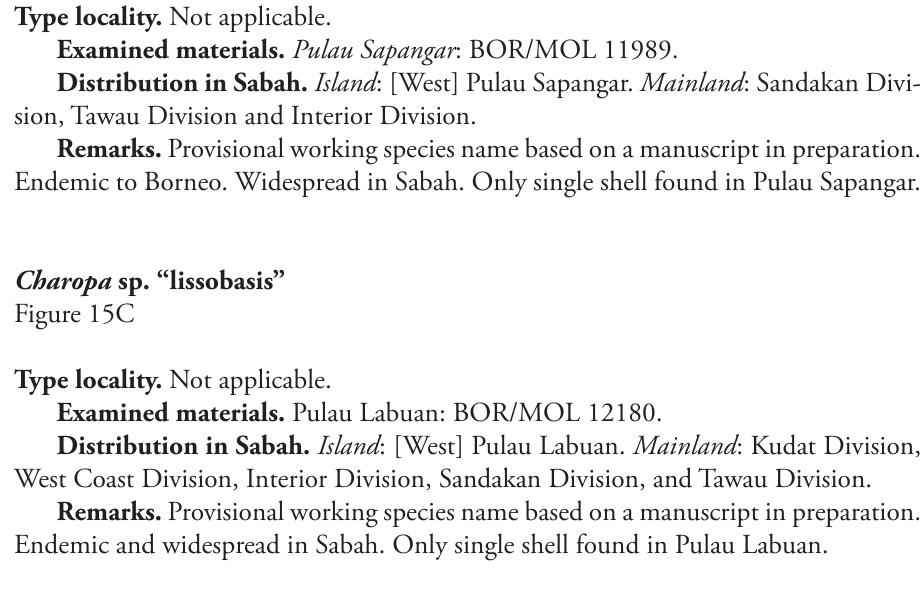
Type locality. Not applicable.